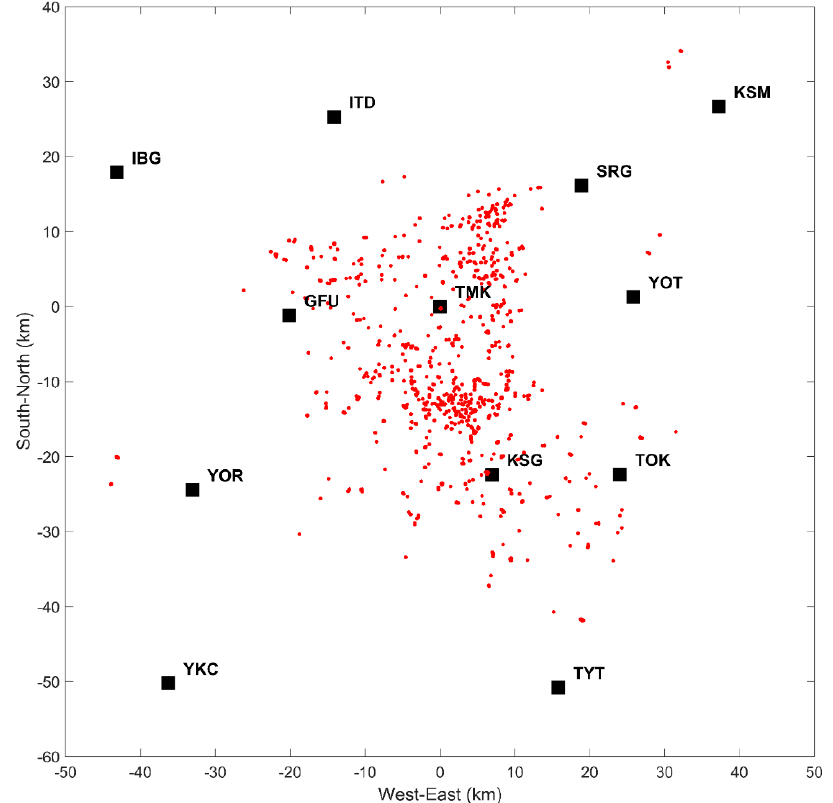
Figure 1. Geographical positions of Fast Antenna Lightning Mapping Array (FALMA) sites in the summer of 2017. Each of the FALMA 12 sites is indicated by a black square and its name is labeled next to the corresponding square. The red dots indicate the locations of 1180 return strokes (RSs) in the 205 studied multiple-termination flashes (MTFs). The latitude and longitude of the site at (0,0) are 35.475 ◦ N and 136.960 ◦ E,